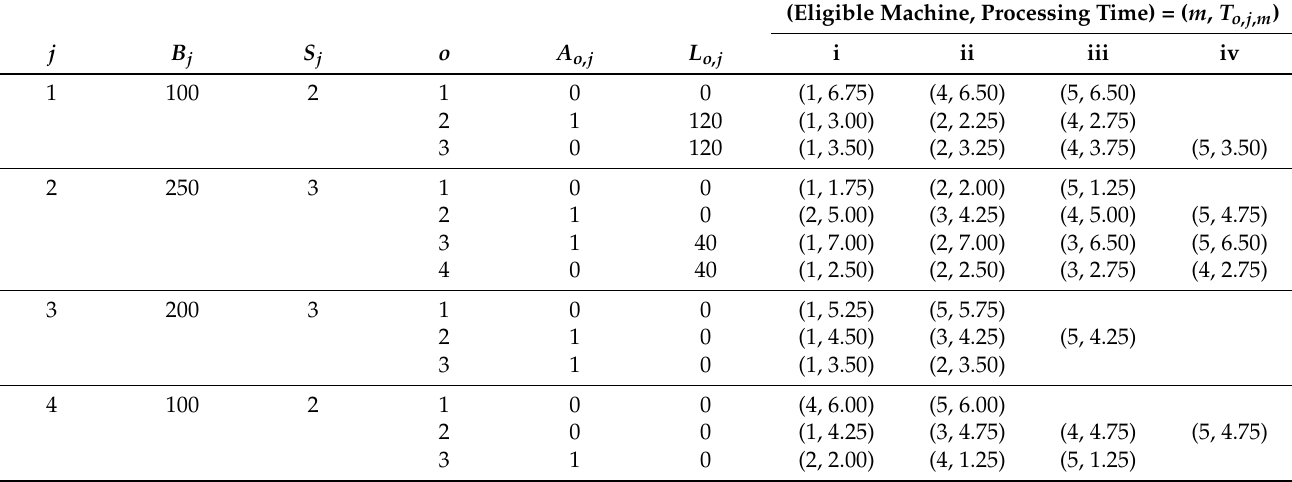
Table 1. Data for jobs for Problem-1.